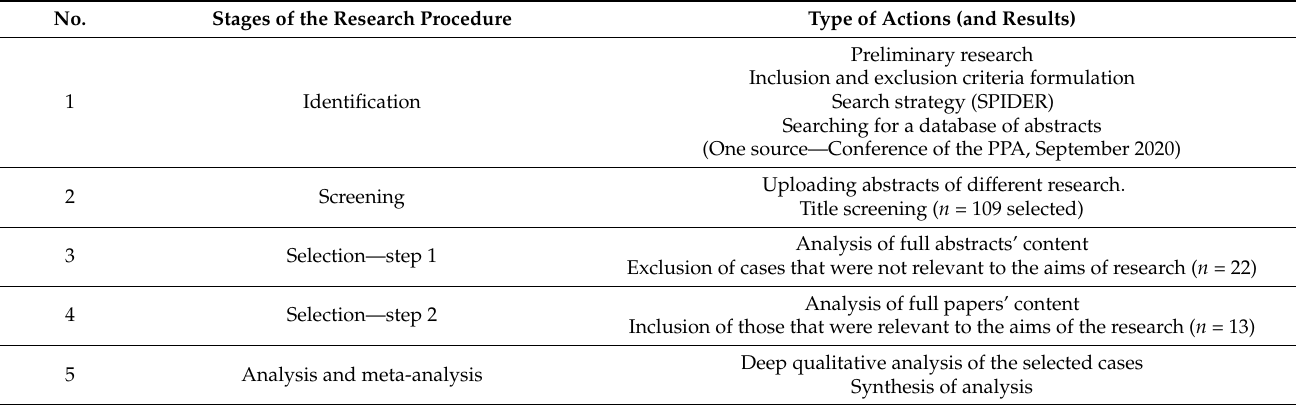
Table 1. Description of research procedure